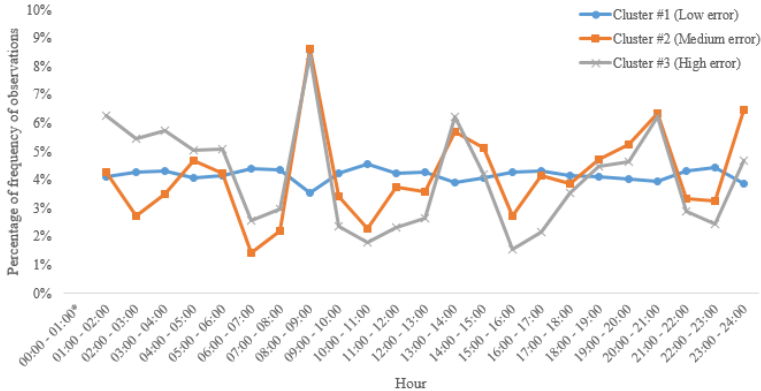
Figure 8. Percentage of frequency of observations per hour and cluster. Cluster #1 (Low Error) is the one with the highest number of observations, being the frequency of observations almost constant across hours of the day, ranging from 3.52% to 4.56%. Clusters #2 (Medium error) and #3 (High error) behave in quite different ways.